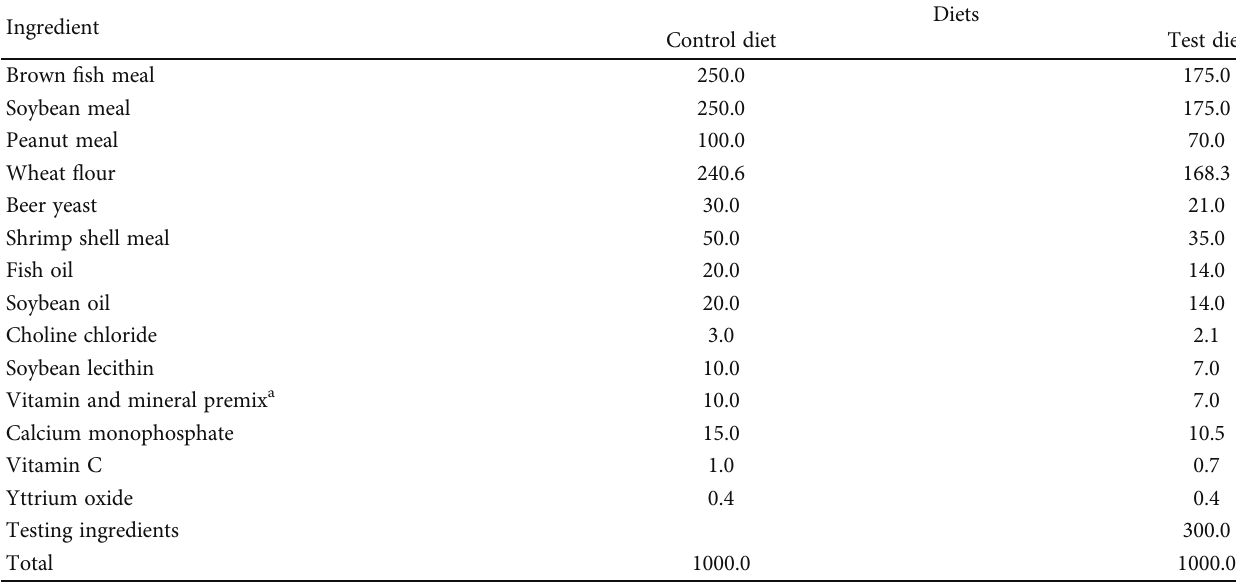
Table 1: Formulation of experimental diets (g/kg dry